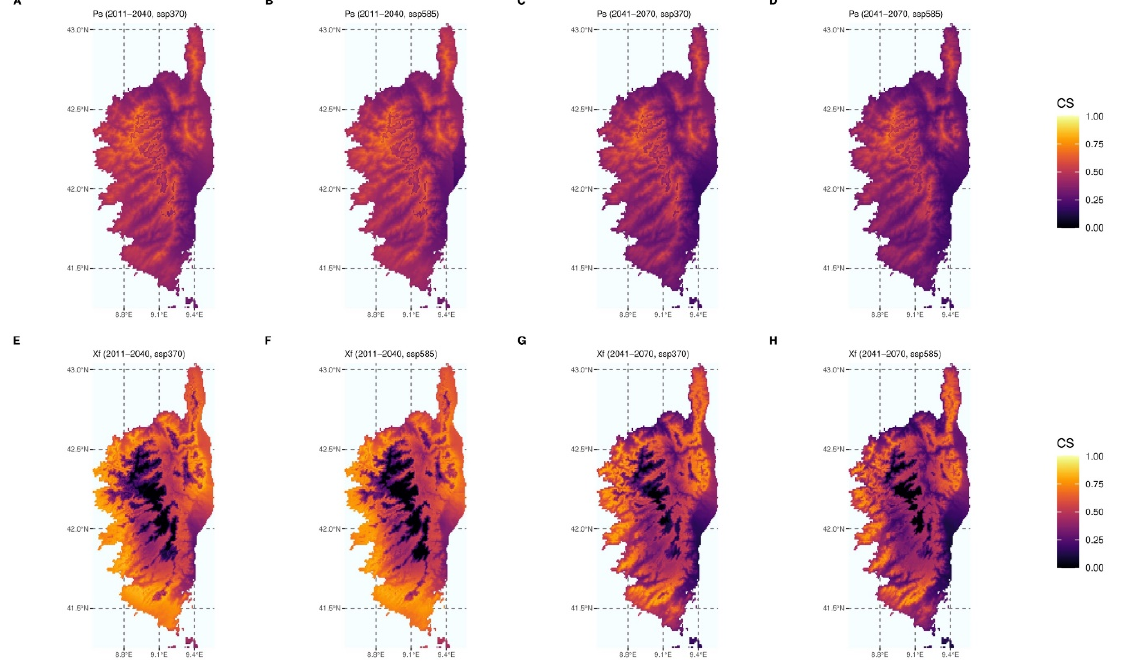
Figure 5. Species distribution modelling. Consensus models showing climate suitability (CS) for P. spumarius (Ps, ( A – D )) and Xf ssp. multiplex (Xf, ( E – H )) according to two time periods (2011–2040 and 2041–2070) and two shared socio-economic pathways (SSP370 and SSP585). Climate suitability